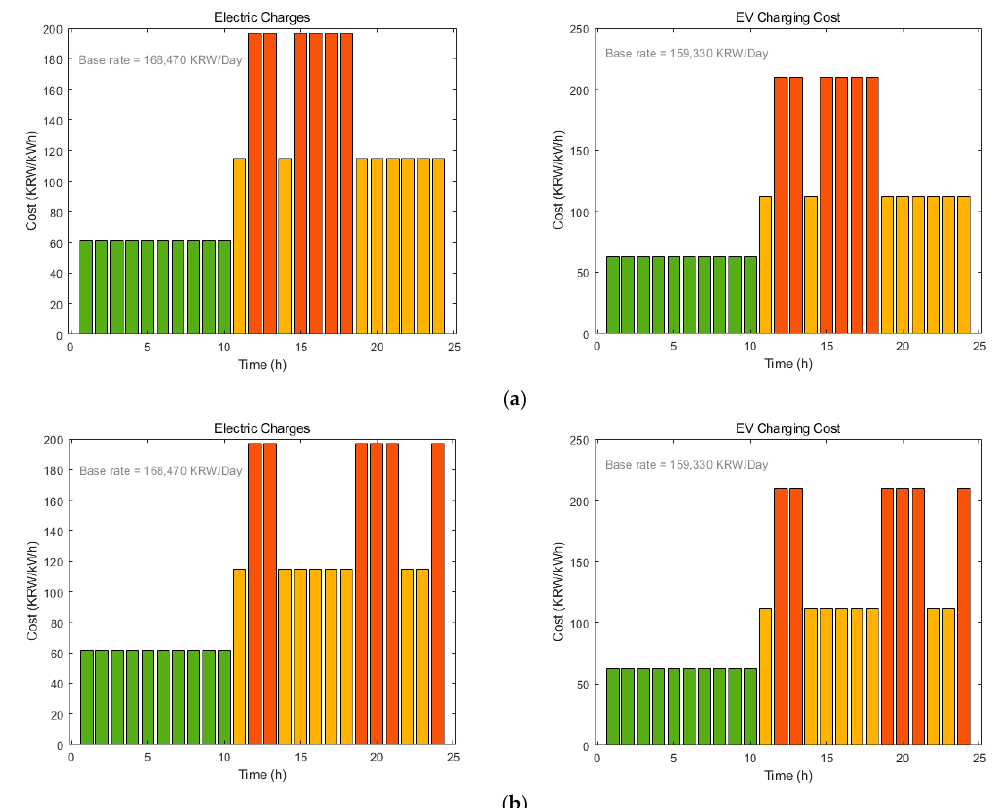
Figure 4. Electricity cost for general use and EV charging in ( a ) summer and ( b ) winter. Table 1. Electricity charge data.